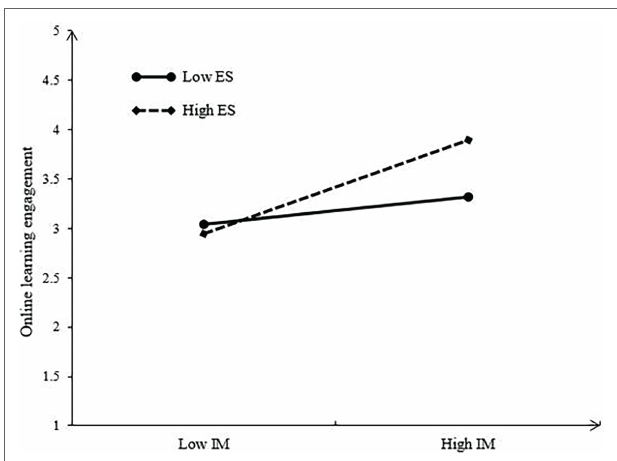
FIGURE 1 | The moderation plot for teacher emotional support. IM, student intrinsic motivation and ES, teacher emotional support.